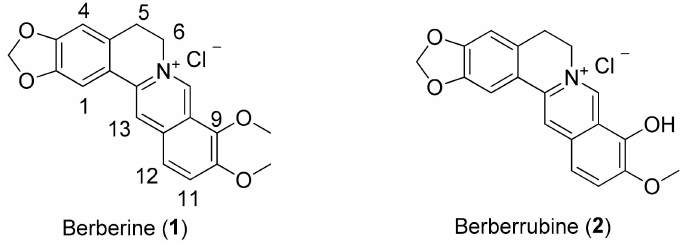
Figure 1. Chemical structures of berberine ( 1 ) and berberrubine ( 2